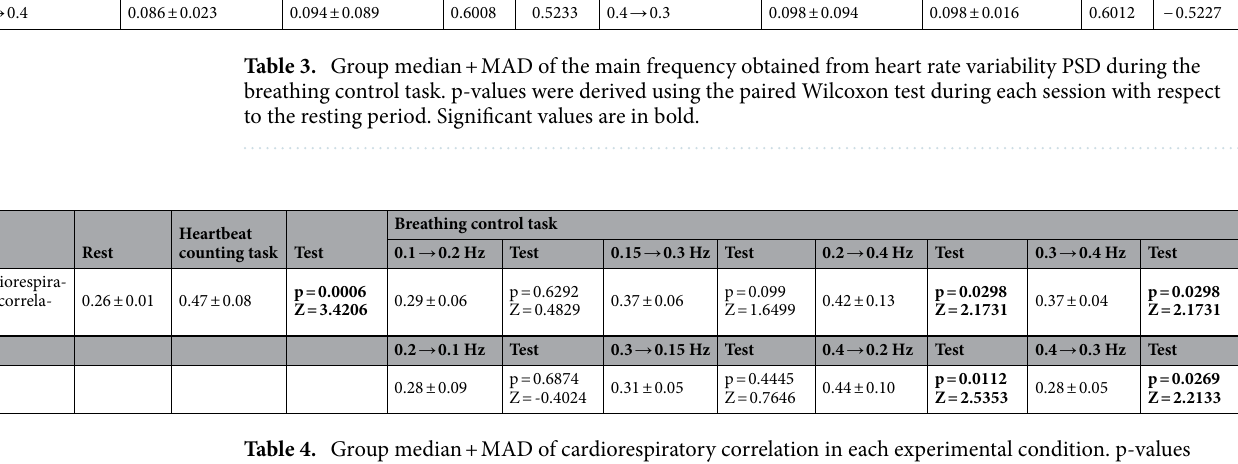
Table 4. Group median + MAD of cardiorespiratory correlation in each experimental condition. p-values correspond to the paired Wilcoxon test of each session with respect to the resting condition. Significant values are in